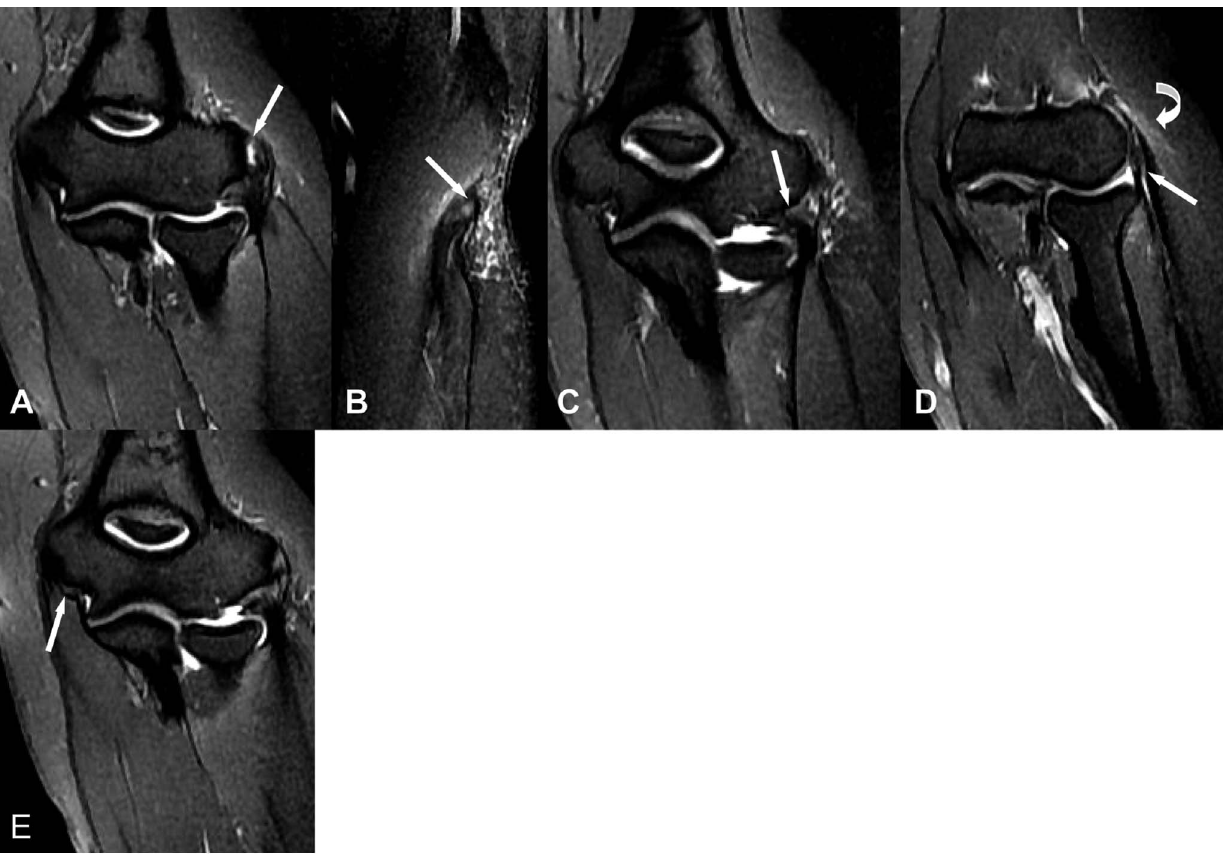
Figure 1. A 36-year-old female with left elbow pain about 1 month. (A,B) Coronal fat-suppressed FSE T2-weighted image shows abnormal fluid signal intensity affecting about 50% of the CET thickness (white arrow), demonstrating moderate injury. (C) Coronal fat-suppressed FSE T2- weighted image shows thickening and abnormal mildly increased signal intensity within the LUCL origin (white arrow), which suggests mild injury. (D) Coronal fat-suppressed FSE T2WI shows thickening and mildly increase signal intensity within the RCL (white arrow), demonstrating mild injury. Intramuscular edema shows as high-signal-intensity focus is seen within the extensor carpi muscle (white curve arrow ). (E) Coronal fat-suppressed FSE T2-weithted image shows mildly increased signal intensity within the proximal MCL (white arrow), a finding suggestive of mild